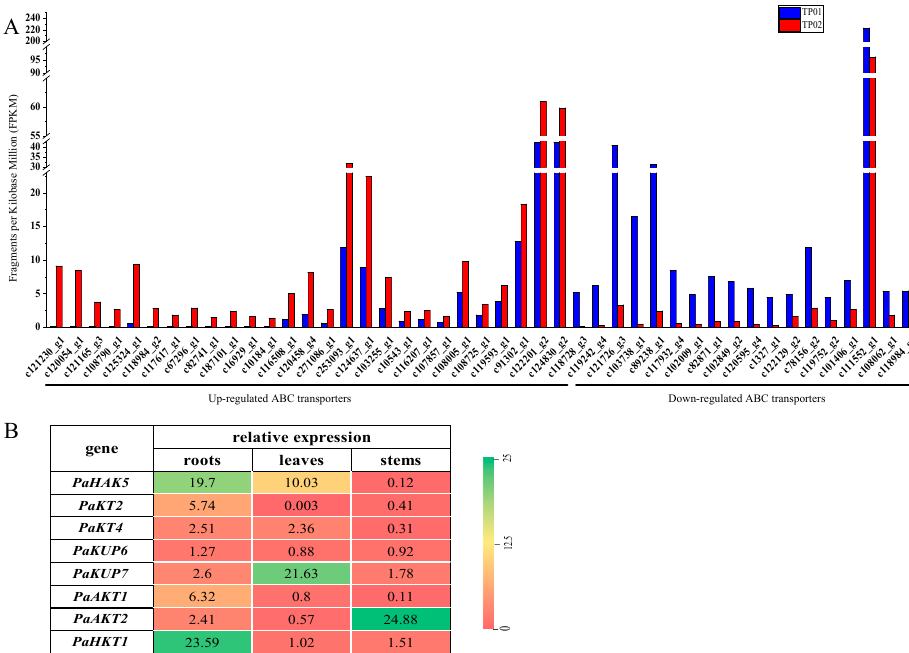
Figure 7. ( A ) Potassium starvation significantly regulated the expressions of ABC transporter genes. The values represent fragments per kilobase million (FPKM). The sample under 3.0 mmol/L K + treatment (average K + treatment) was represented by TP01, and the sample under K + starvation was represented by TP02. ( B ) Low potassium induced the expression of high-affinity K + transporter genes in different tissues. The value represents the ratio of gene expression in K + deficiency vs. normal K + level.